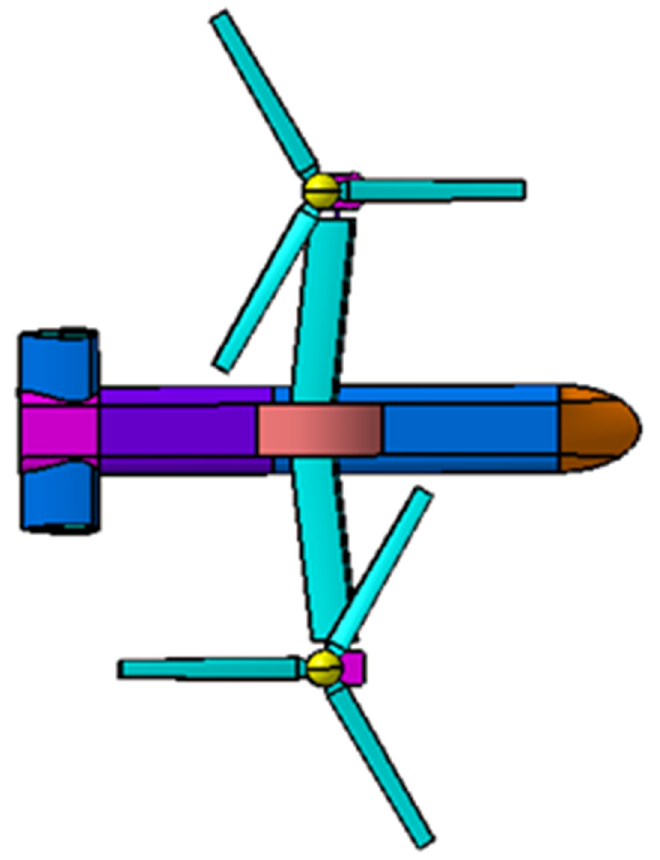
Figure 22. View of a coaxial tilt-rotor aircraft with PPC1. Table 20. Noise SPL and average RCS values with PPC1.